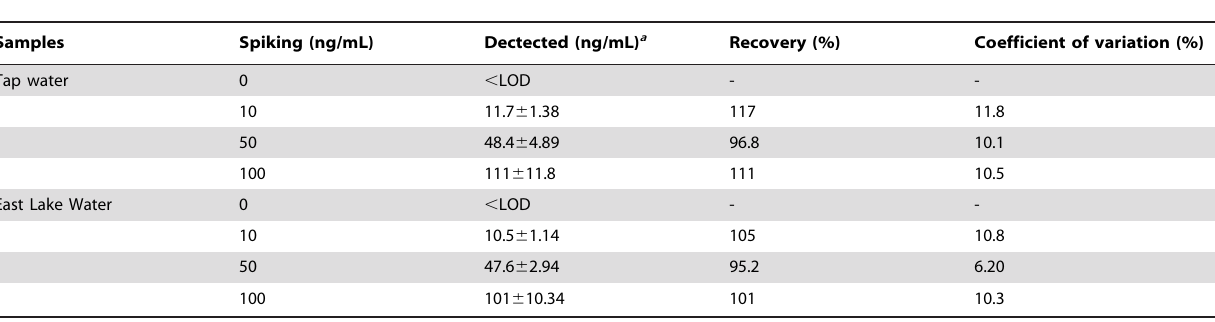
Table 6. Recovery of DBP spiked into water samples.